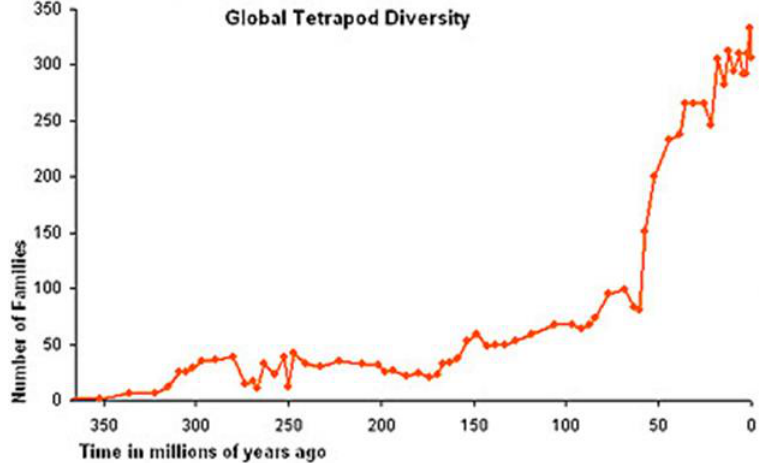
Figure 11. Global Tetrapod